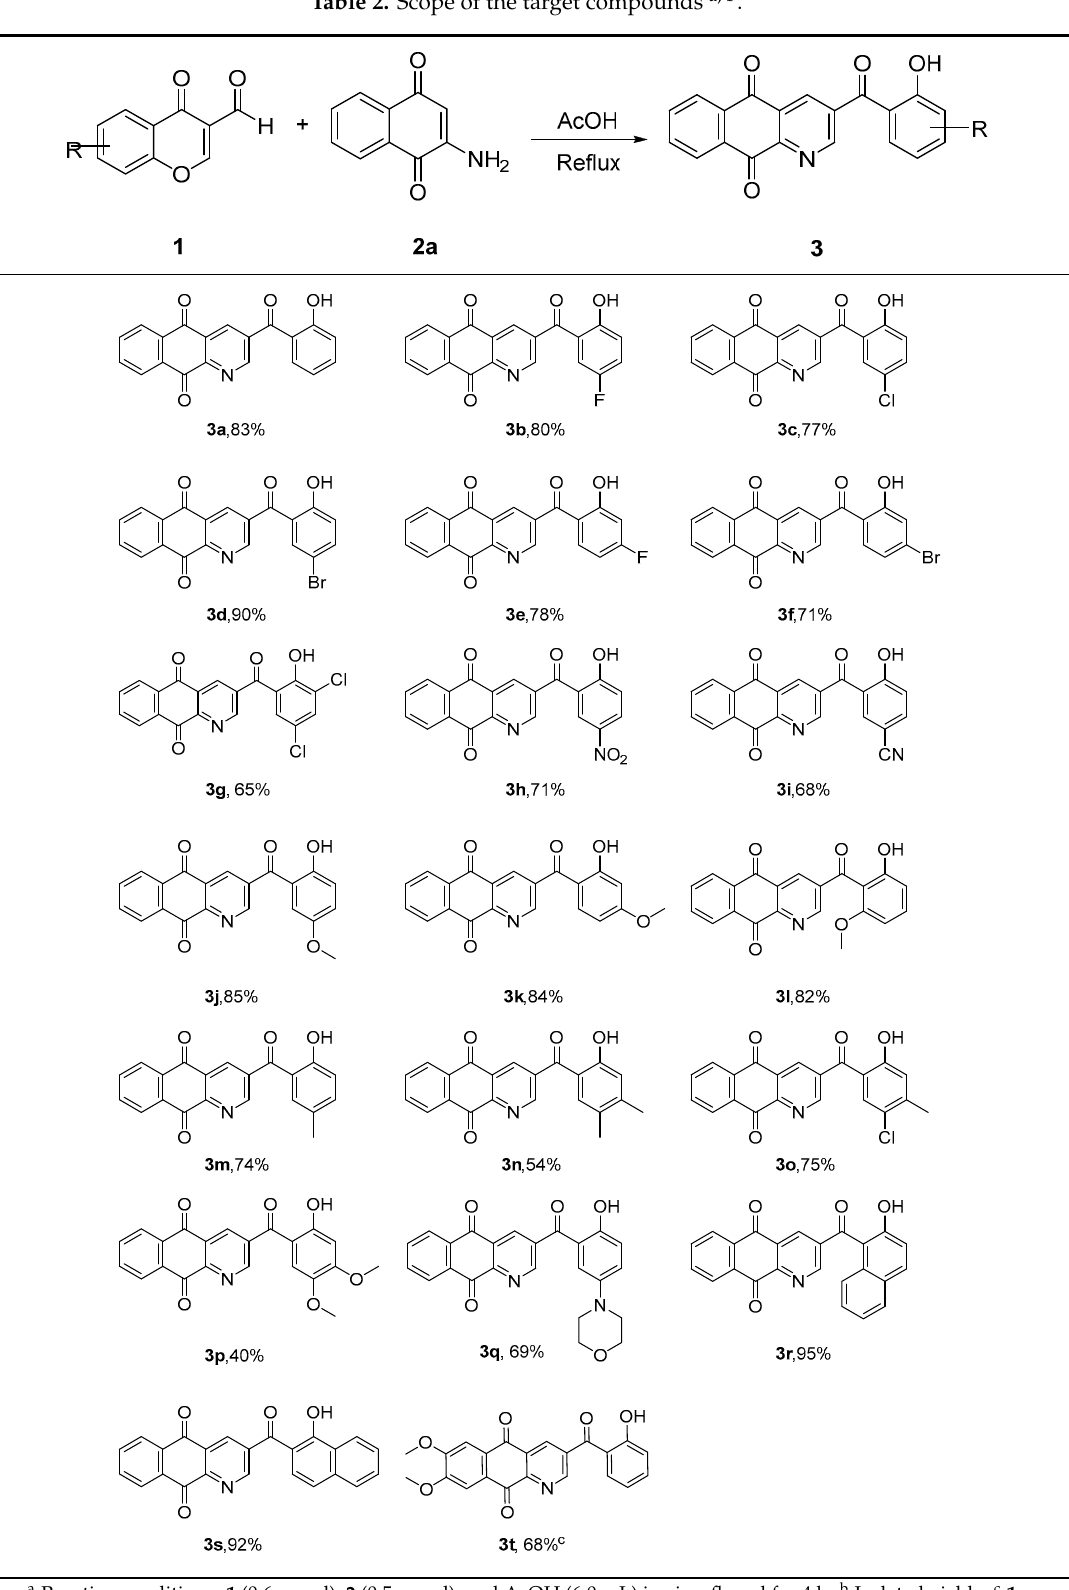
Table 2. Scope of the target compounds a, b.